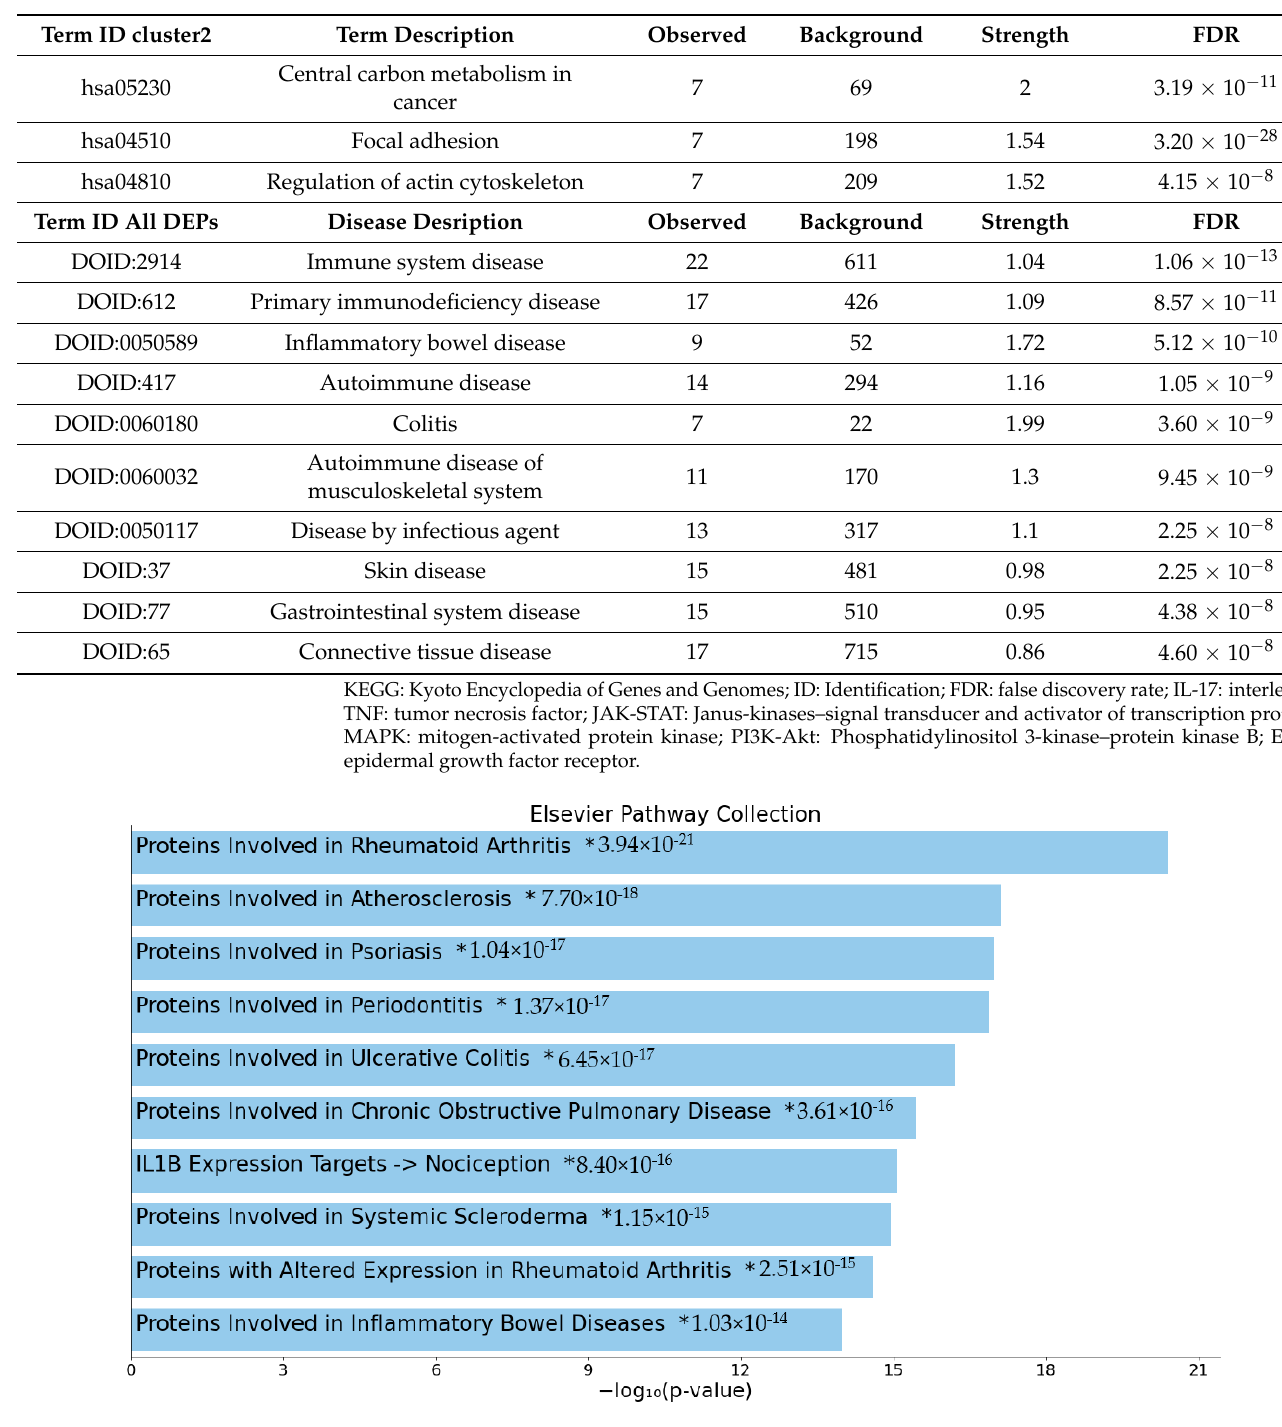
Figure 6. Bar chart with the top ten Elsevier Pathways that are over-represented in the first-order protein – protein interaction network of major dysmood disorder.*: the term has a significant ad- justed p -value (<0.05) p -value